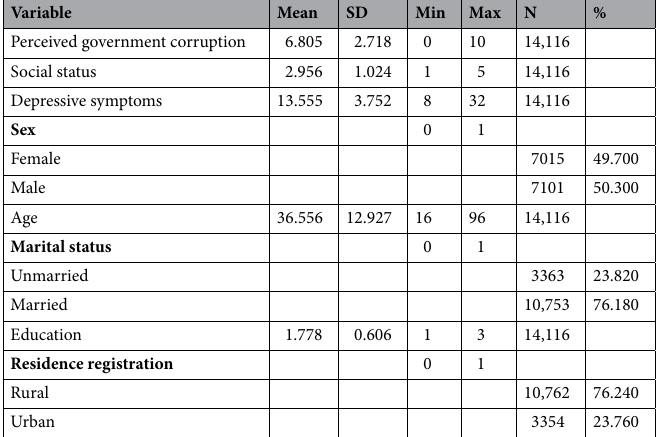
Table 2. Descriptive statistics (N = 14,116).